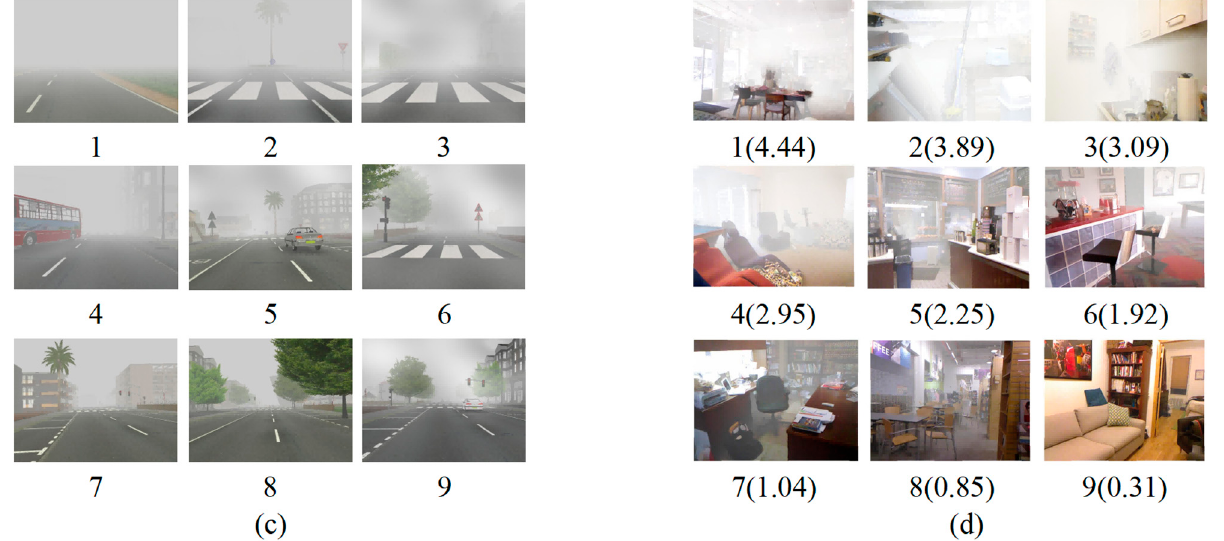
Figure 6. Images from the synthetic FROSI dataset with 7 haze levels ( a ), from the real FHVI dataset with 6 haze levels ( b ), from the ExFRIDA dataset with 9 haze levels ( c ), and from the INDF dataset with 9 haze levels ( d ).